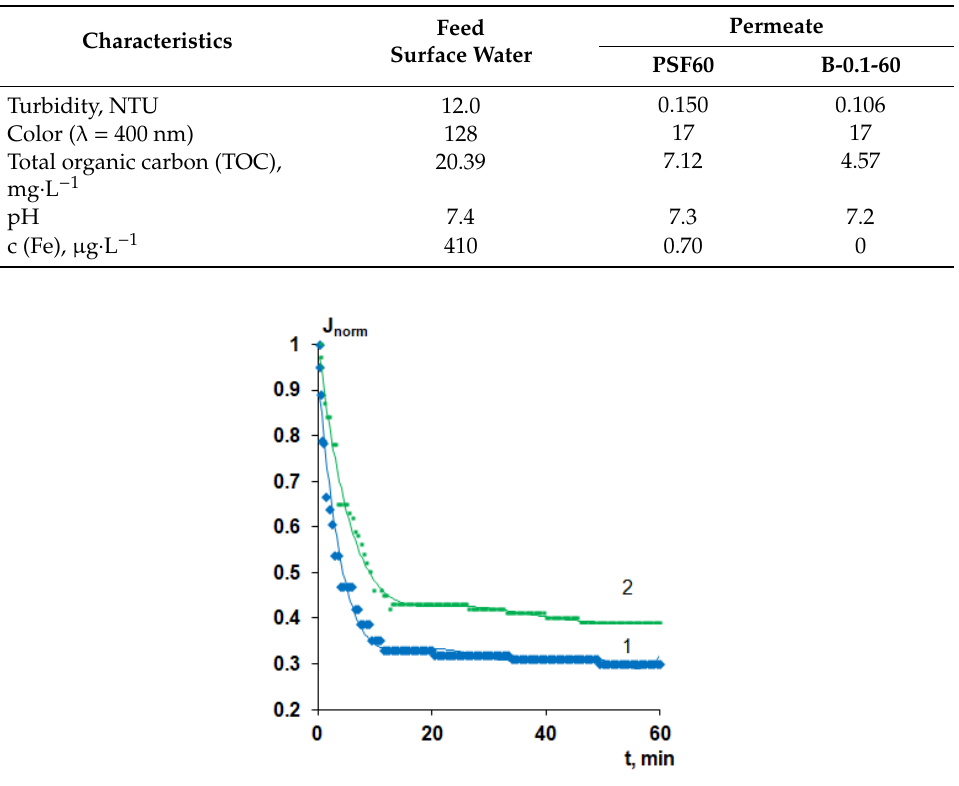
Figure 15. Time-dependent normalized flux ( J / J 0 ) of surface water (Slepianski Channel, Minsk, Belarus) during ultrafiltration of reference and modified PSF-based membranes: 1 — PSF-60, 2 — B-0.1- 60.